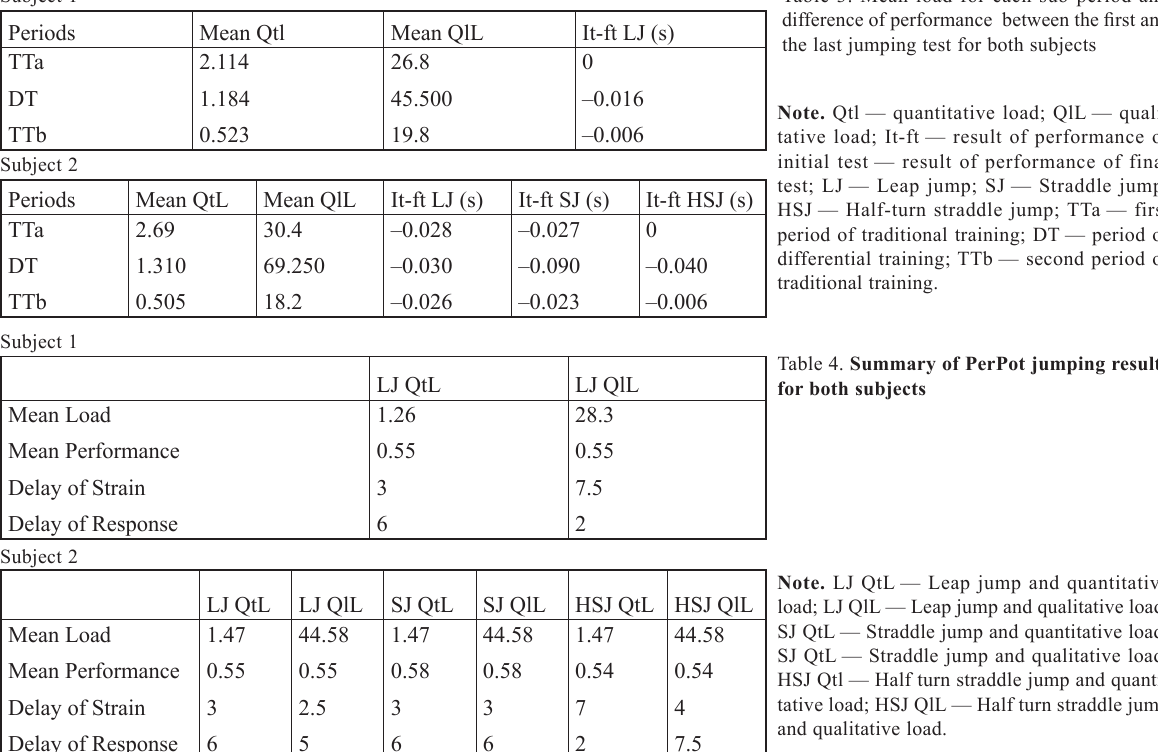
Table 4. Summary of PerPot jumping results for both